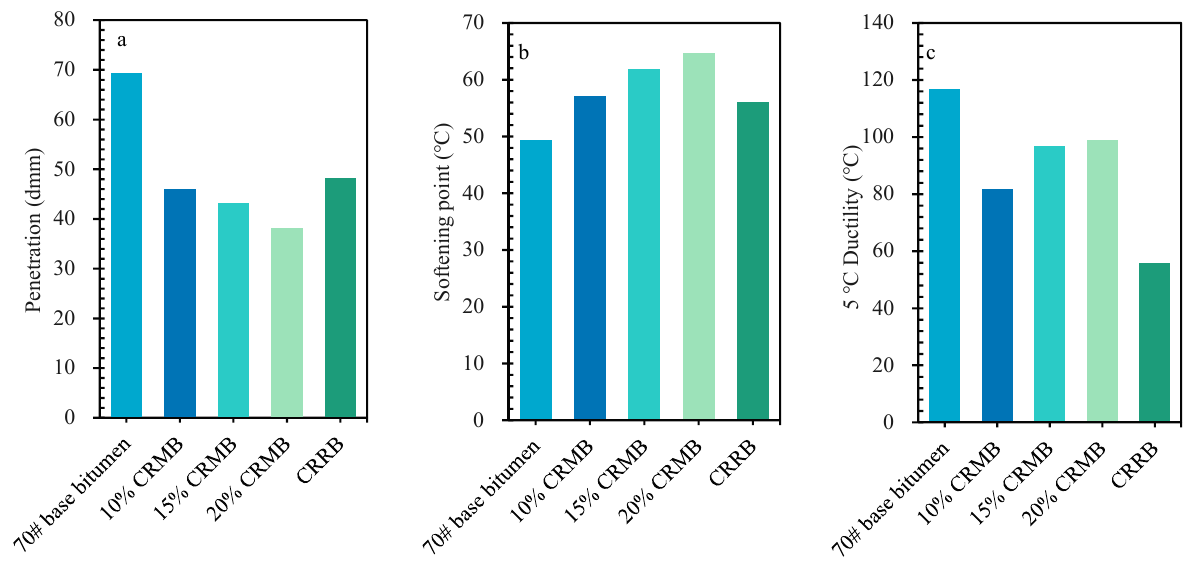
Figure 3. Physical properties of bitumen: ( a ) penetration; ( b ) softening point; ( c ) ductility.